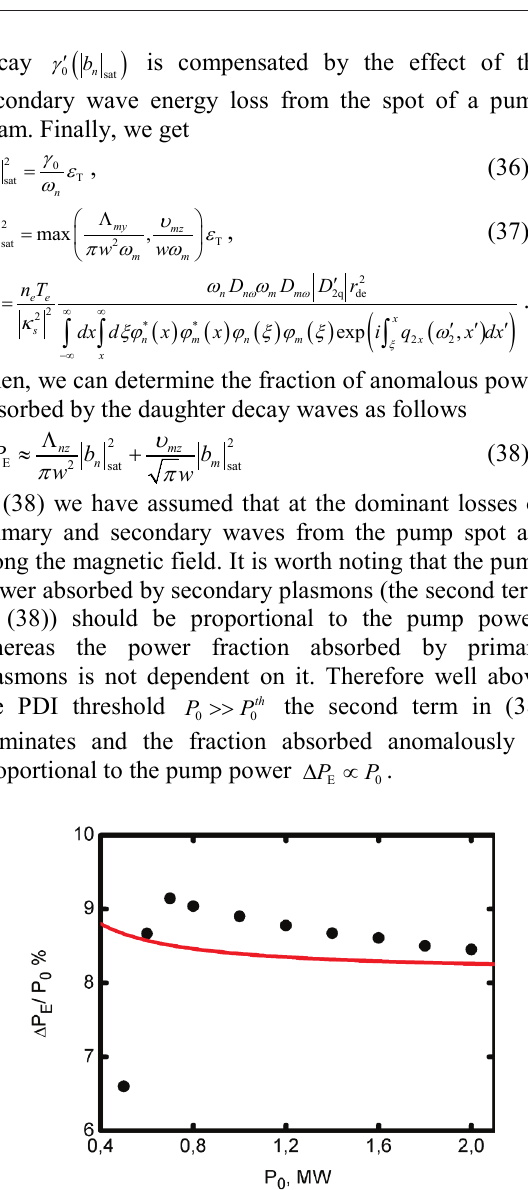
Fig. 4. The anomalous absorption rate derived numerically (scattered symbols) and predicted by the asymptotic equation (38) valid at are shown; th 125 kW P = 0 0